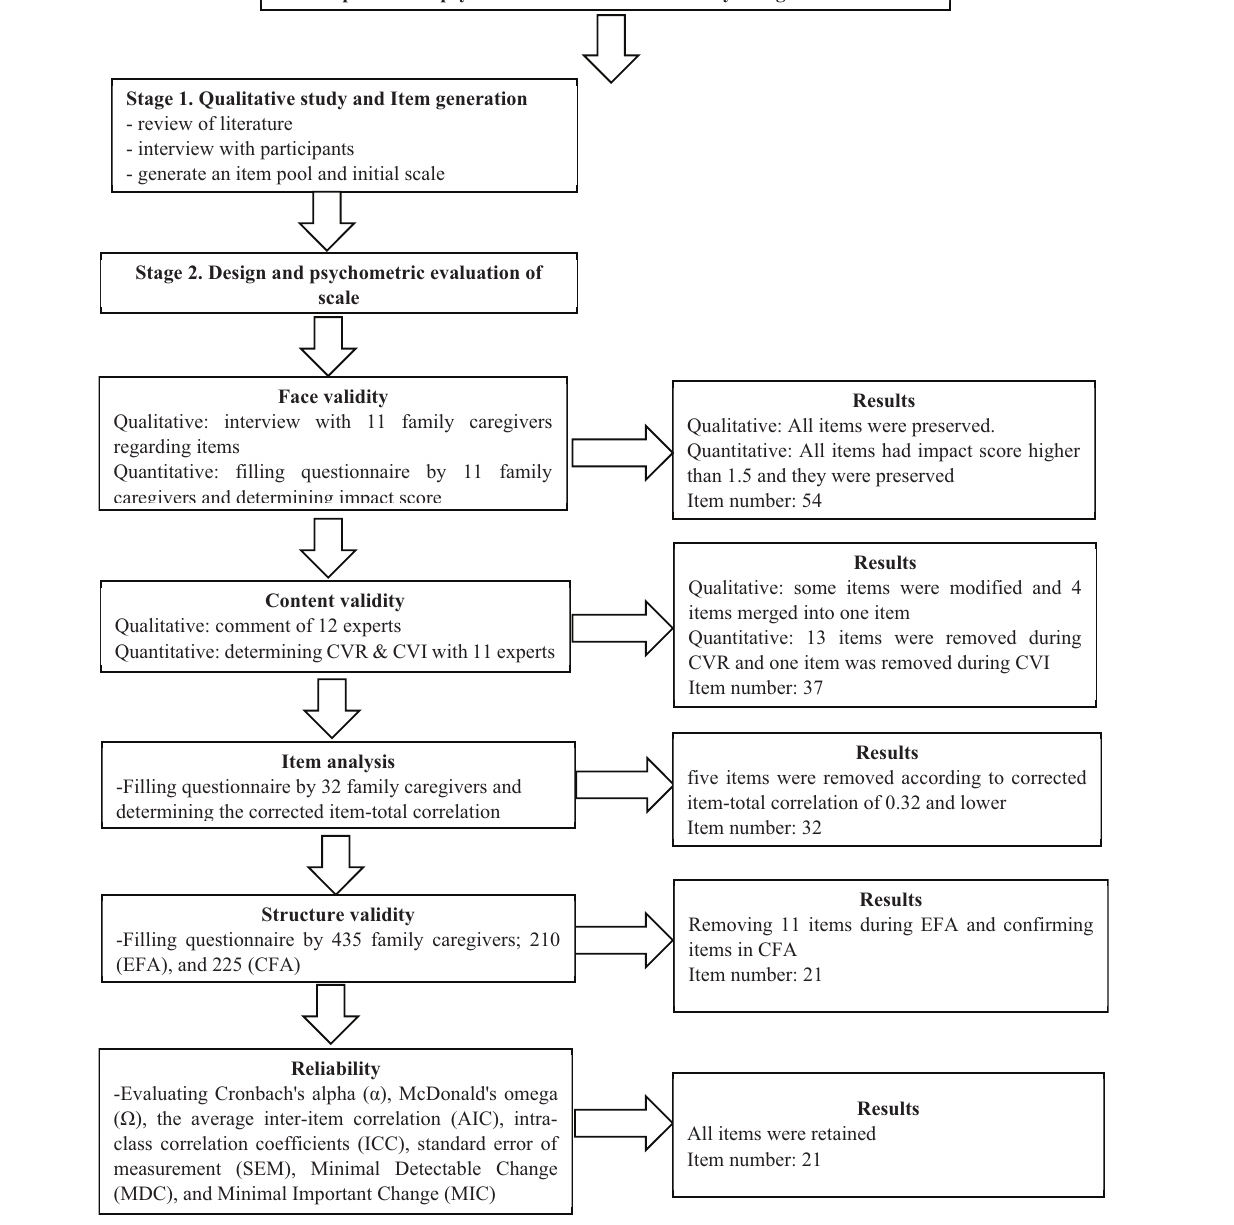
all values in the HTMT matrix should be less than 0.85 (Henseler et al.,